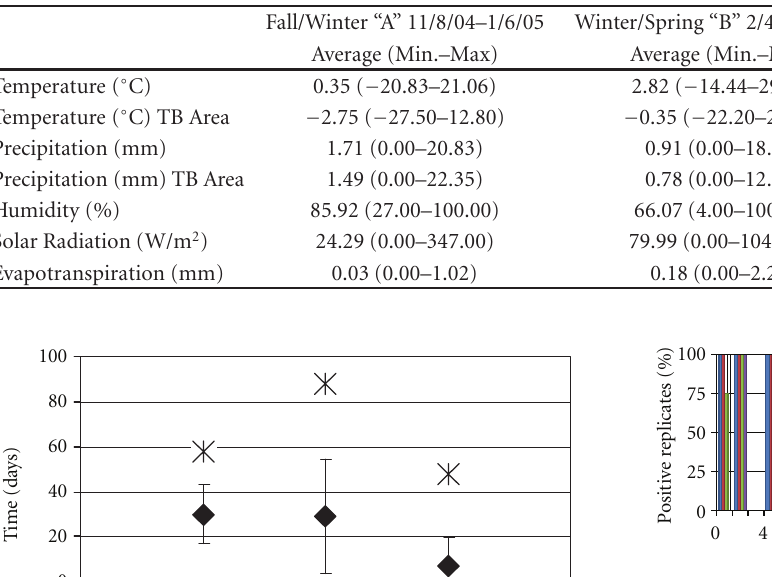
Table 1: Weather conditions recorded over the three sampling periods at the site of the Mycobacterium bovis environmental persistence study and temperature and precipitation data from the TB area of Michigan for the same time.